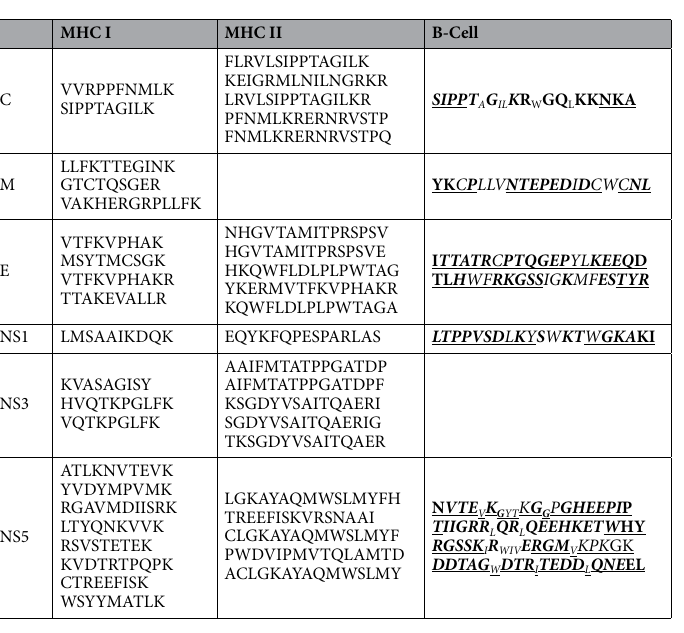
Table 6. Composite table of the prioritized epitopes for vaccine development. Underlined residues are structurally coiled whereas the amino acids (not underlined) are structurally helix. For surface accessibility, subscripted amino acids are buried as against the exposed amino acids. In addition, regions of the B-cell epitopes predicted by SVMTrip with a score of 1.00 were